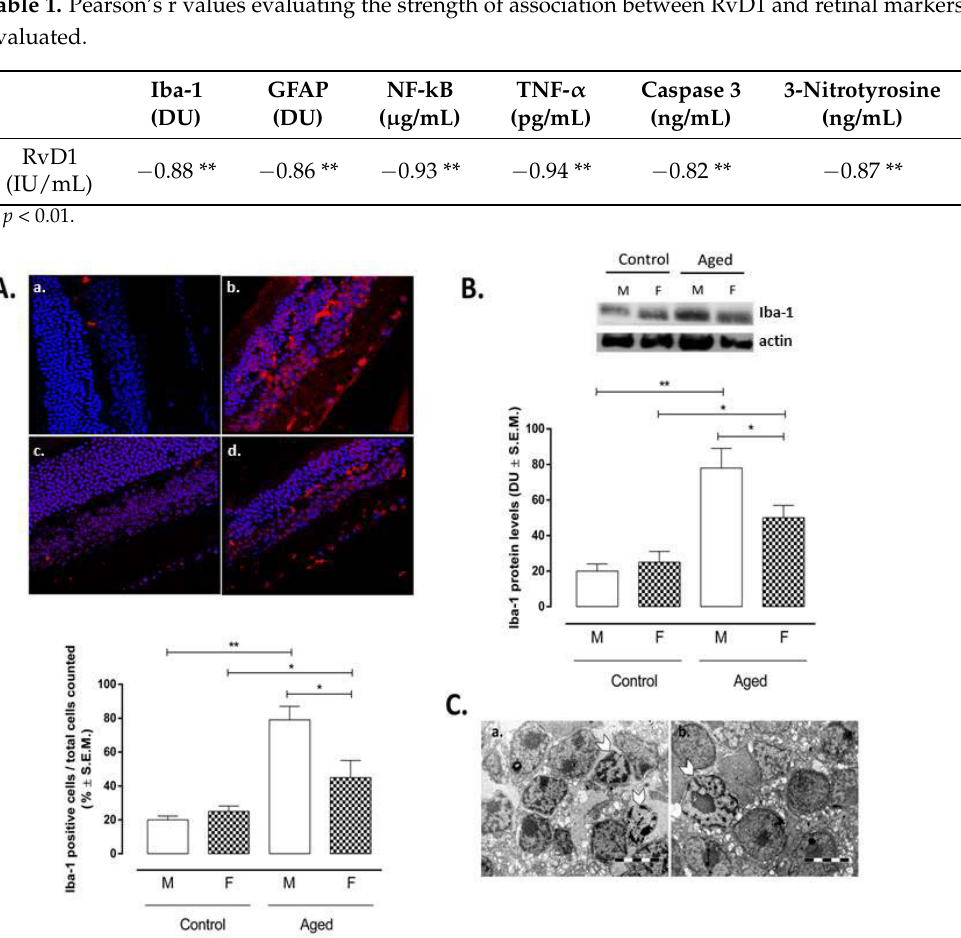
Figure 2 . Microglial activation in aged and younger (control) retina. ( A ) Immunofluorescence stain- ing in control and aged retina. Immunofluorescence images and data (% ± S.E.M.) are representative of 10 observations for each individual/group; Iba-1 immunolabeling of the retina indicates less re- active microglia in the controls (a. male; c. female); aged samples (b. male; d. female) contain acti- vated macroglia cells which were positive for Iba-1; ** p < 0.01; * p < 0.05 vs. control; magnification 63×; ( B ) Western blotting results are expressed as the mean ± S.E.M. of n = 10 retinas per group. M: males; F: females; DU: densitometric units; ** p < 0.01; * p < 0.05 vs. control; ( C ) electron microscopy evidenced microglial hypertrophy (arrowhead) in the retinal inner nuclear layer (INL) of aged male (a) and aged female (b); bar 5 µm.